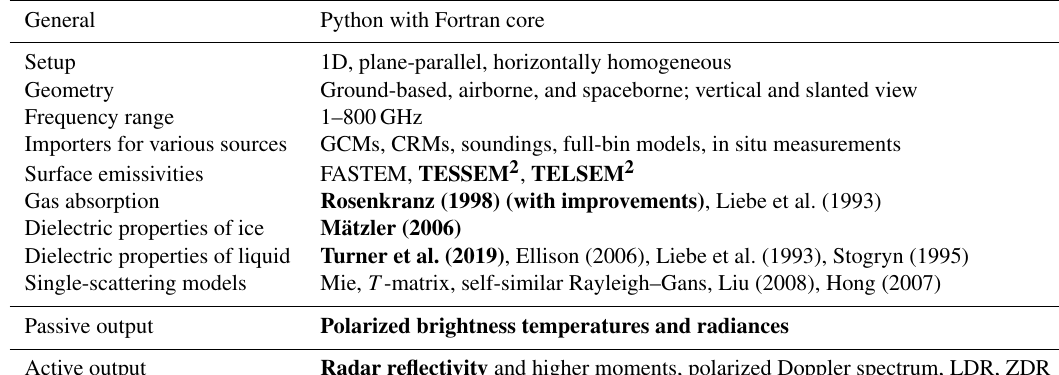
Table 1. Main characteristics and features of PAMTRA. Default options are written in bold.